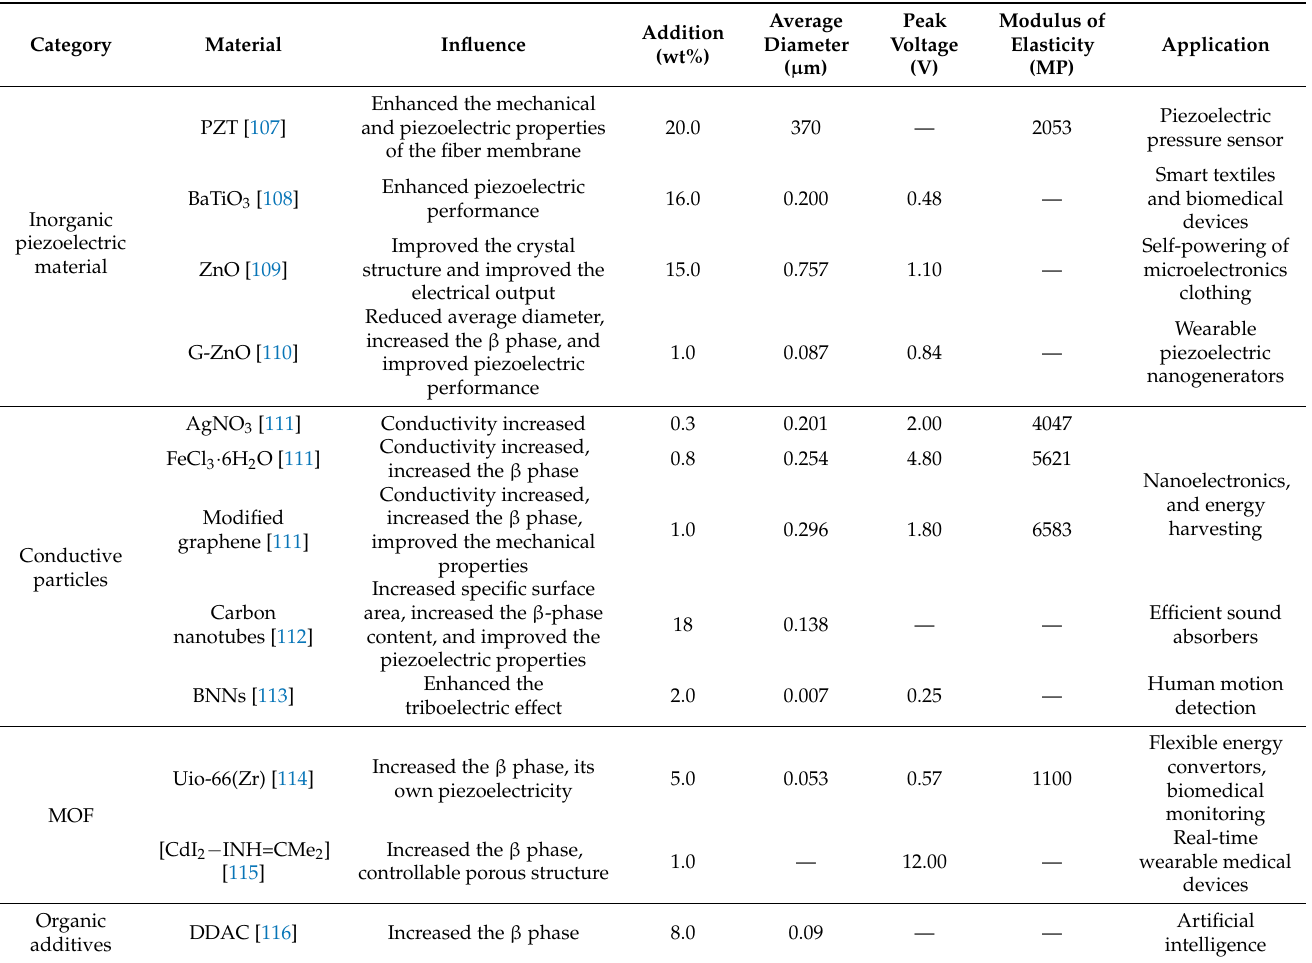
Table 2. The influence of Various additives to